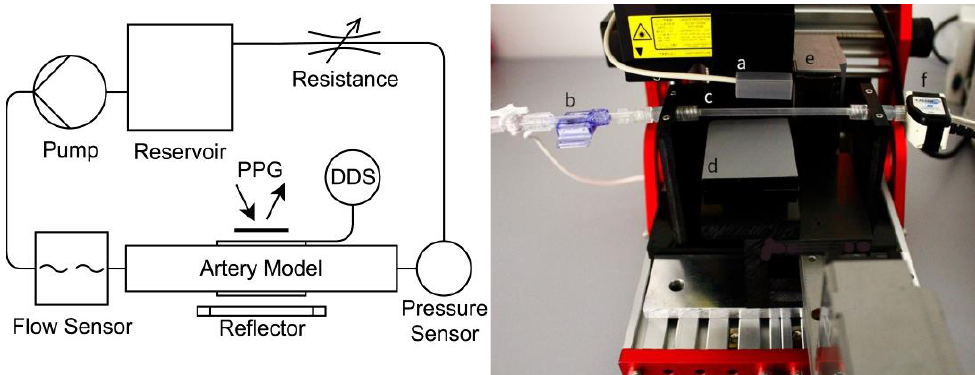
Figure 1. Schematic diagram and photograph of the experimental setup. PPG: reflective PPG sensor, DDS: optical diameter and radial displacement sensor, a: PPG sensor, b: pressure sensor, c: artery model, d: reflector, e: optical diameter/displacement sensor, f: flow sensor.